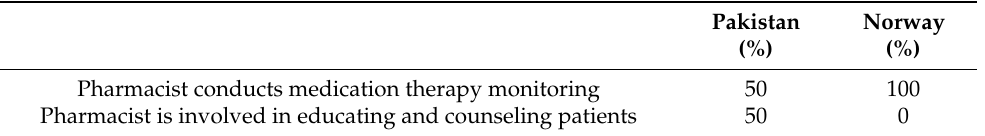
Table 9. Pharmacists’ assessments on monitoring medication